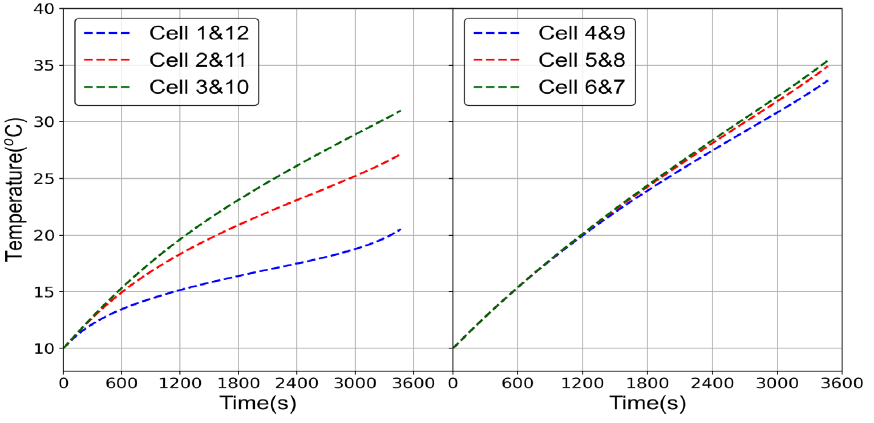
Figure 11. Temperature increase curve of the cells under the inhomogeneous cooling case 13.